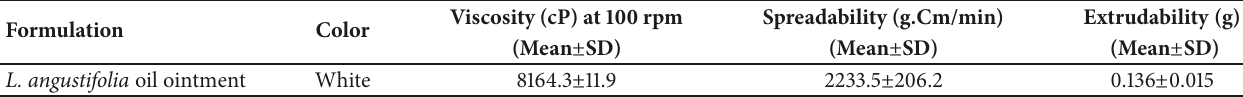
Table 2: Physicochemical evaluation of L. angustifolia ointment